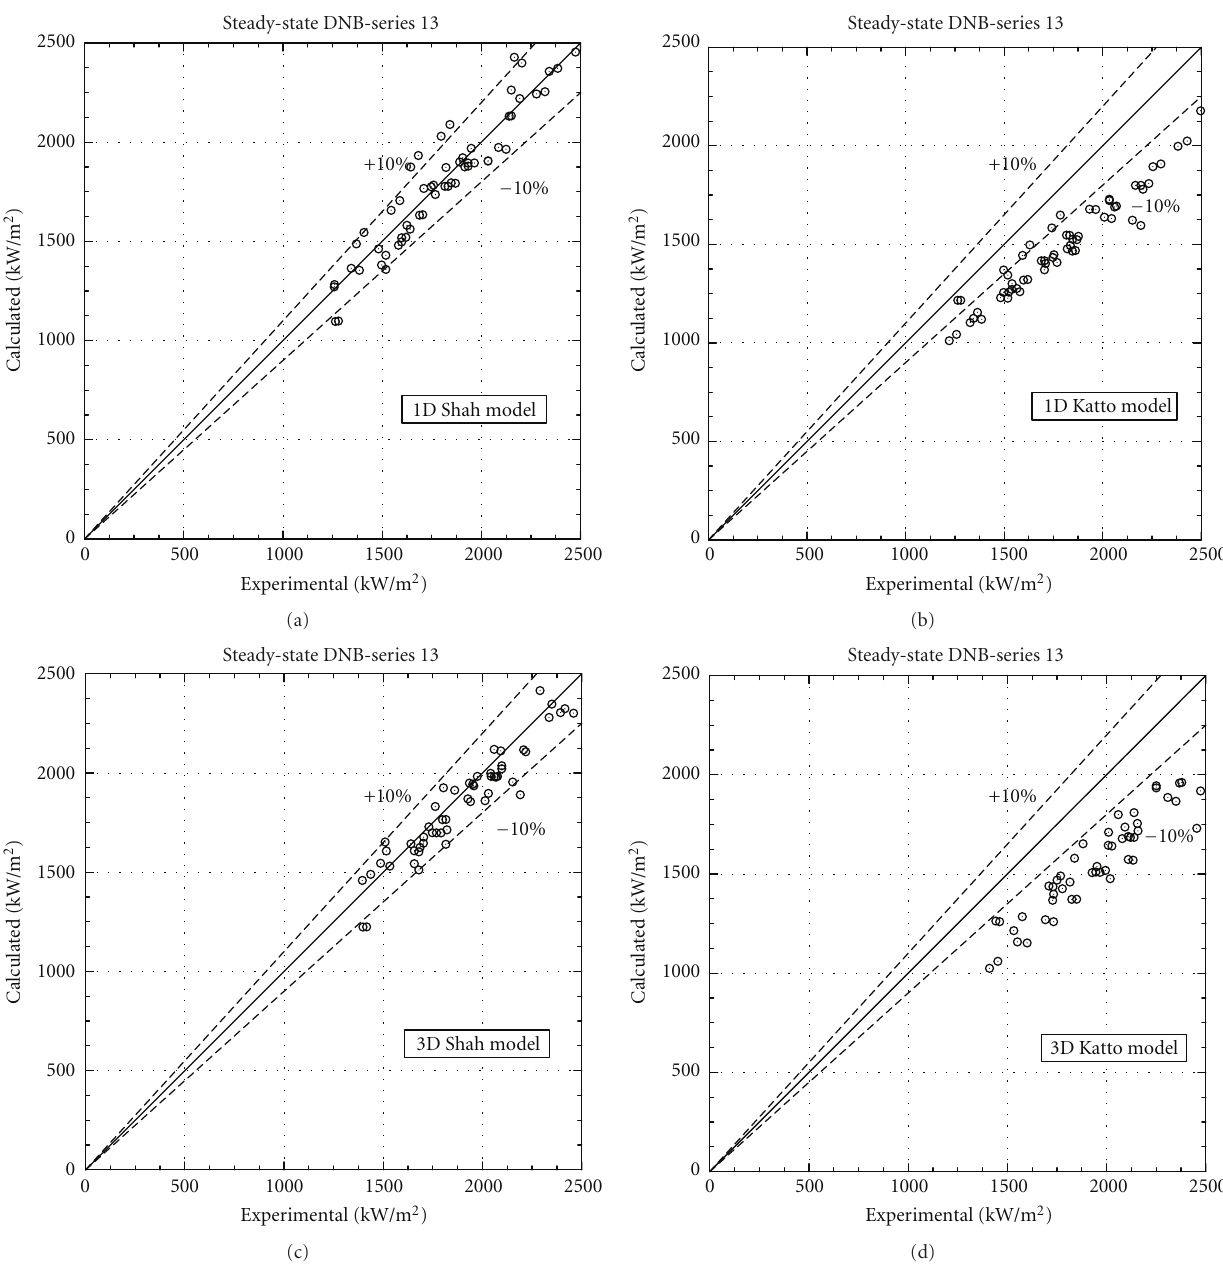
Figure 11: Computed versus experimental critical heat fluxes (Series